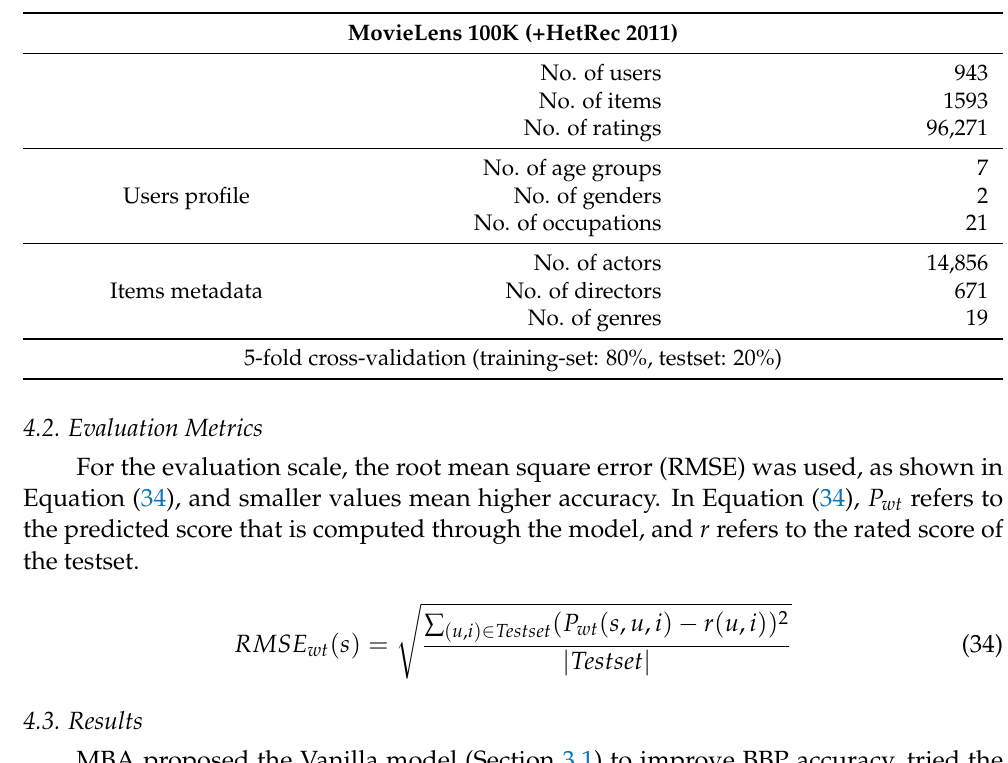
Table 2. Dataset used in